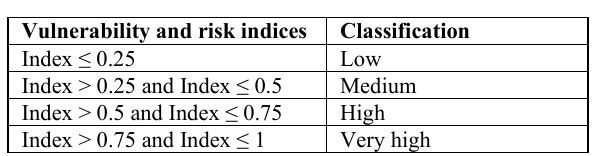
Table 2 . Vulnerability and risk classes. Source: de Vries, 2022